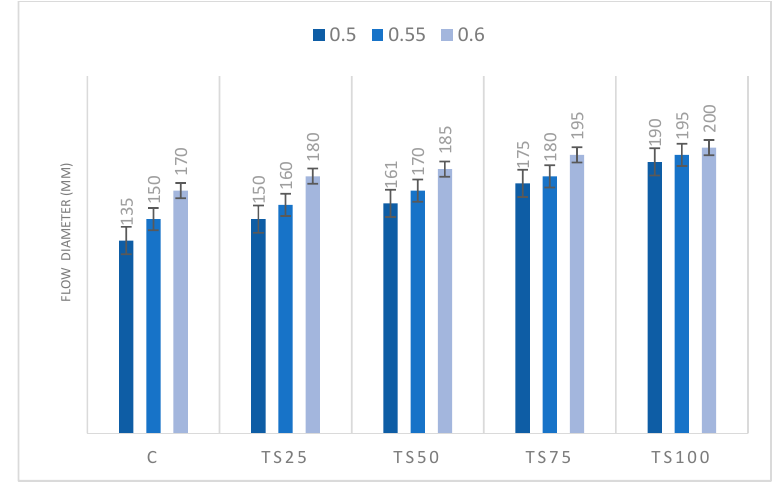
Figure 8. Flow diameters of graded TS at different w / c ratios.